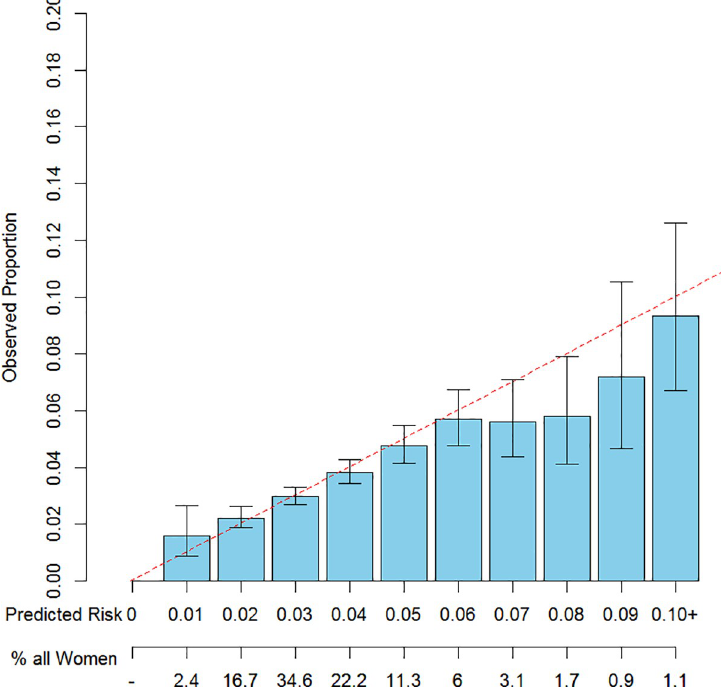
Fig 4. Observed vs. expected counts of 5-year absolute risks vs. 1% risk bins, of 10-fold cross-validated predicted risks using Model 3b.